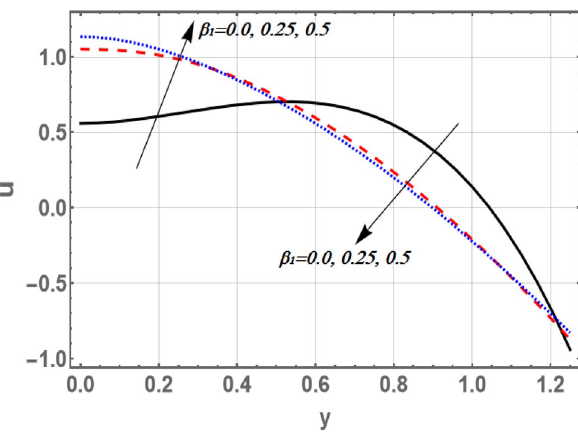
Figure 2. Graph of axial velocity u for different values of β 1 .